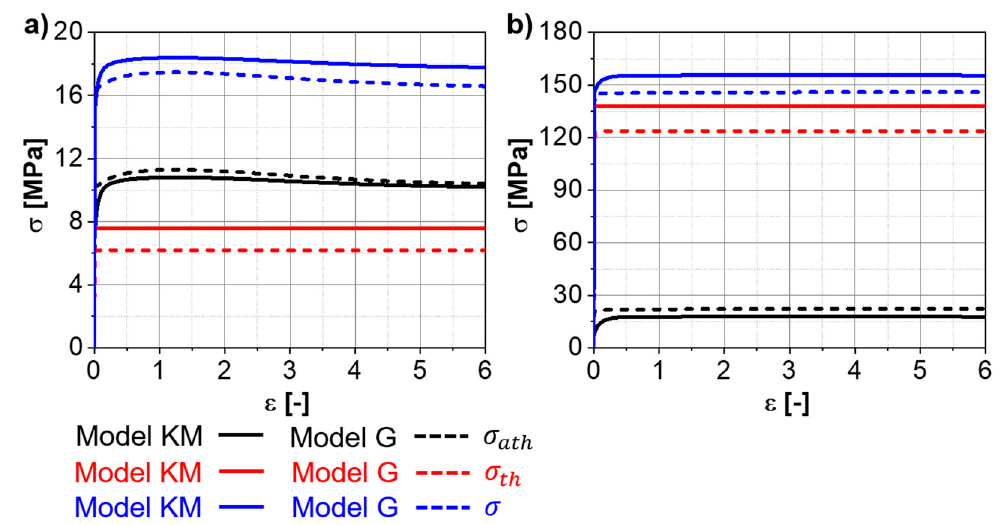
Figure 6. Simulated stress components ( 𝜎 (cid:3028)(cid:3047)(cid:3035) and 𝜎 (cid:3047)(cid:3035) ) and total stress ( 𝜎 ) for the Ti-17 deformed at 970 ◦ C and ( a ) 0.001 s − 1 , ( b ) 10 s − 1 up to large 970 °C and ( a ) 0.001 s − 1 , ( b ) 10 s − 1 up to large strains.